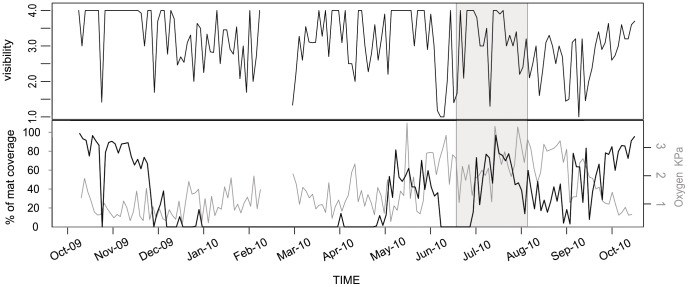
Time series of relative abundance of bacterial mats and visibility between October 6th 2009 and October 18th 2010 in the camera field of view in Saanich Inlet.Top panel is visibility and lower panel bacterial mat coverage. The grey box shows the period characterized by the presence of phytodetritus on the seafloor. The grey line is the partial pressure in dissolved oxygen.